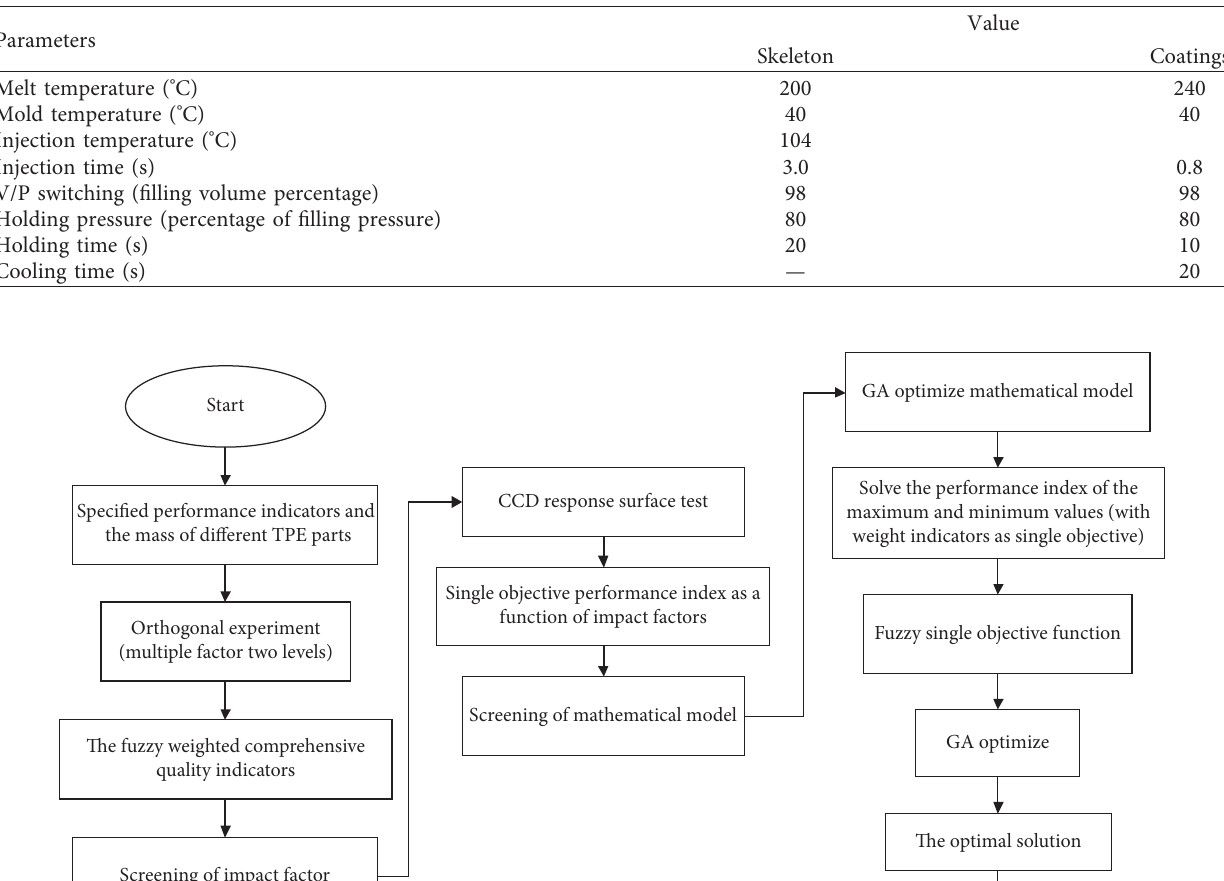
Table 1: Injection